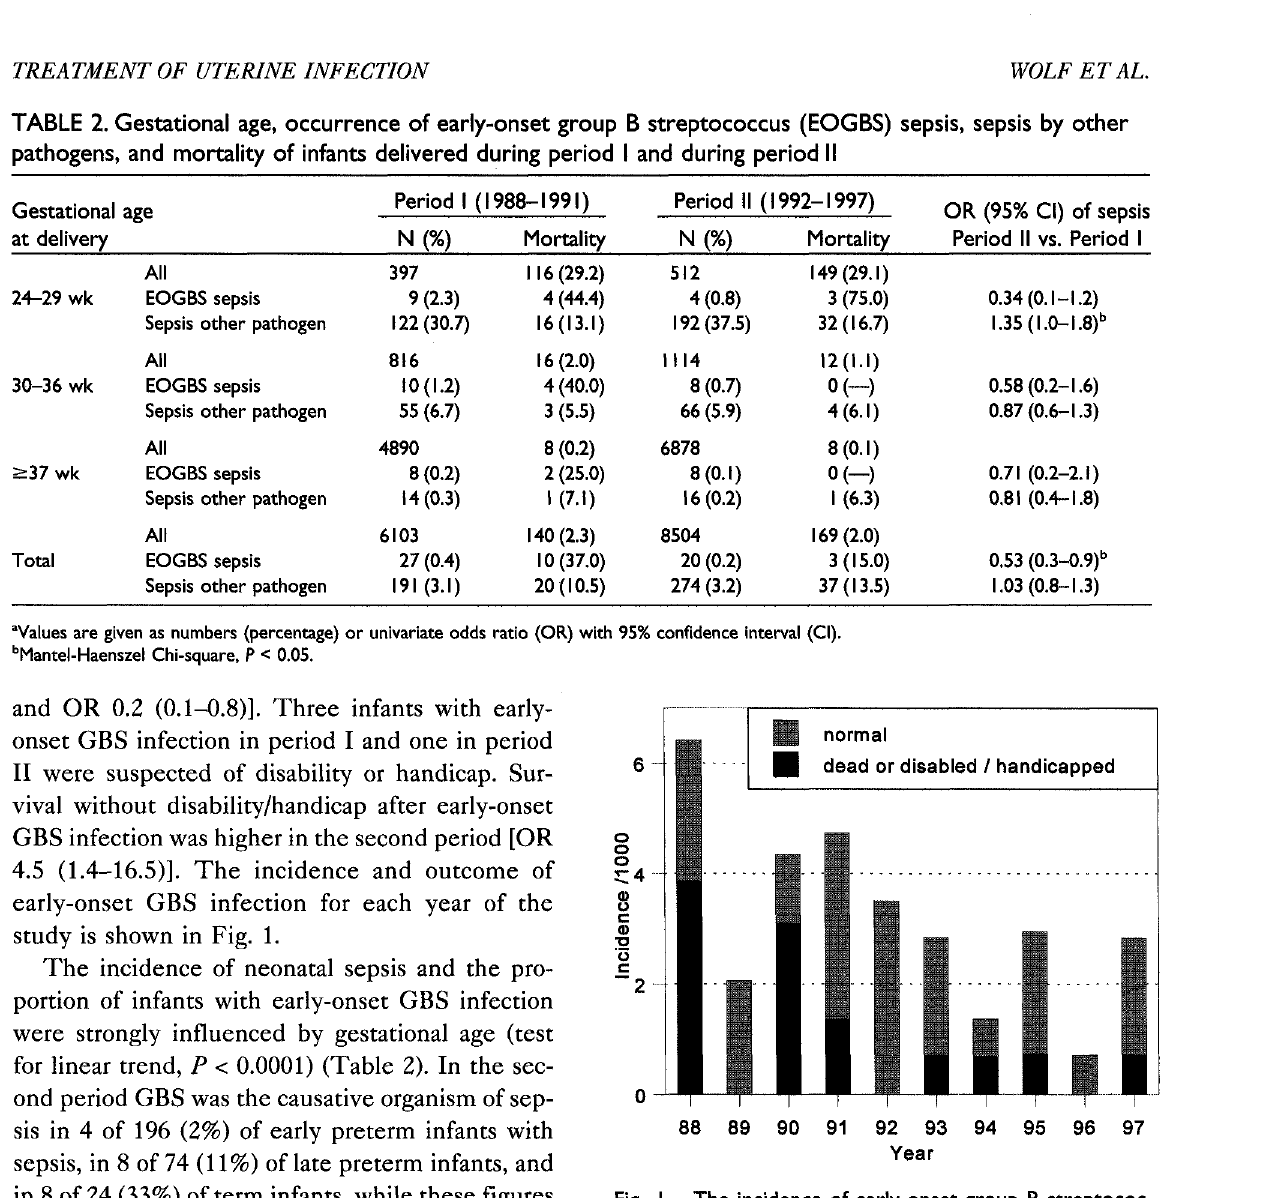
Fig. I. The incidence of early-onset group B streptococ- cus sepsis in each year of the study period. Infants who recovered and infants who died or remained disabled/ handicapped are presented